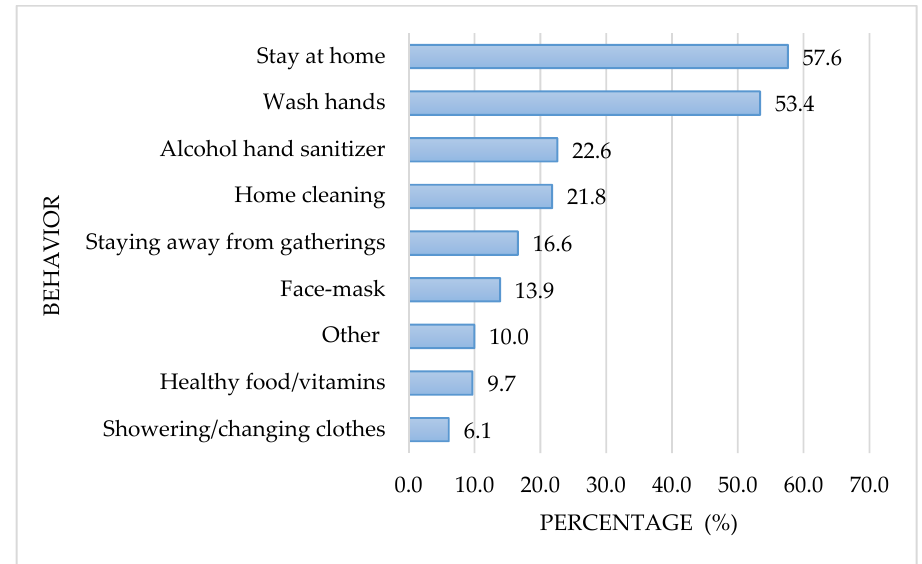
Figure 1. Frequency (%) of preventive behaviors associated with the coronavirus (COVID-19) pandemic in adults ( ≥ 65 years old) in Mexico City.